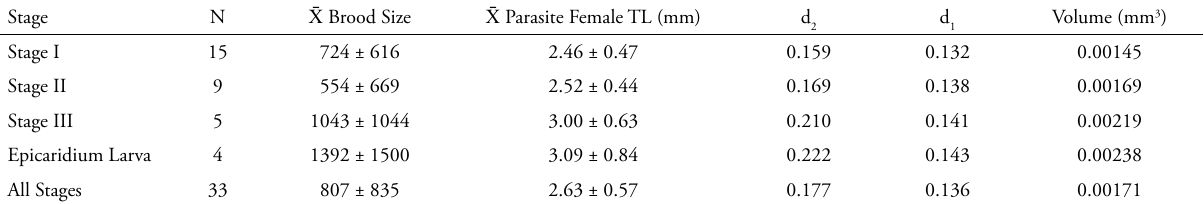
Table 3. Urobopyrus processae . Fecundity and embryo, epicaridium volume of U. processae infesting shrimp Ambidexter symmetricus , based on developmental stage.